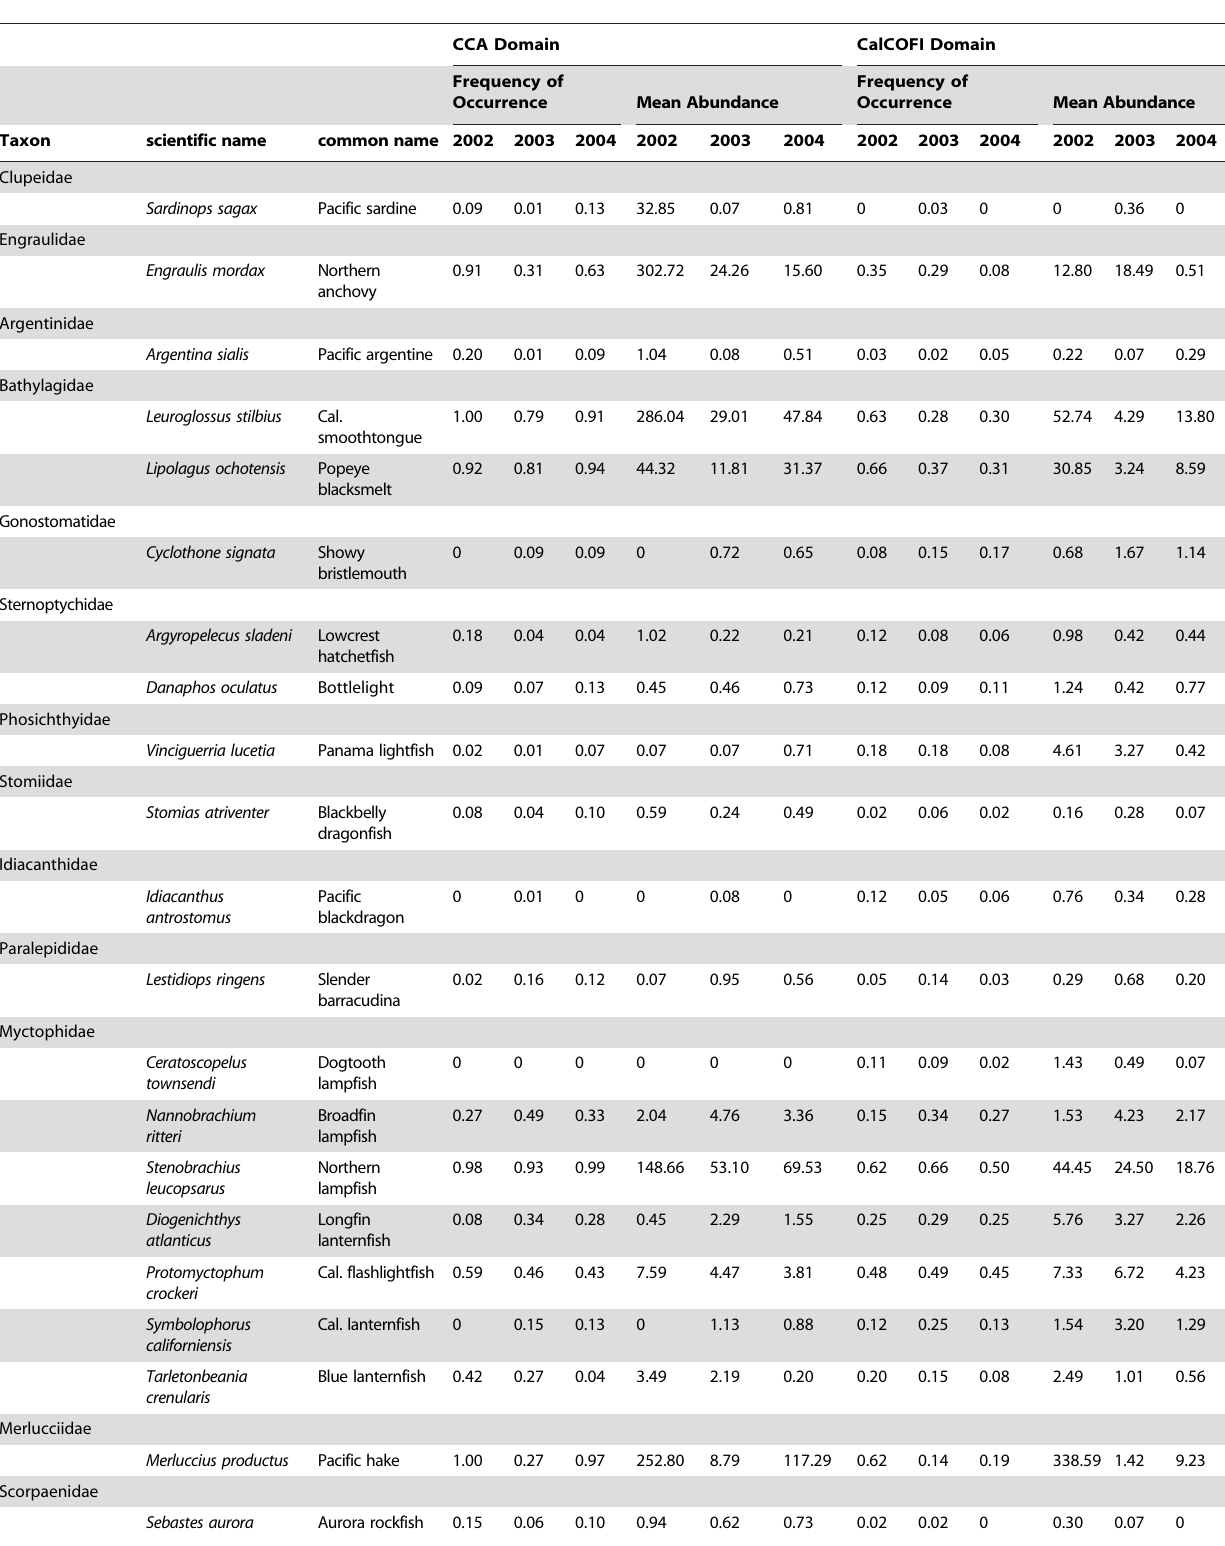
Table 1. Frequency of occurrence, mean abundance, and proportion of abundance constituted by individual ichthyoplankton taxa for each sample year within the CCA and CalCOFI sampling